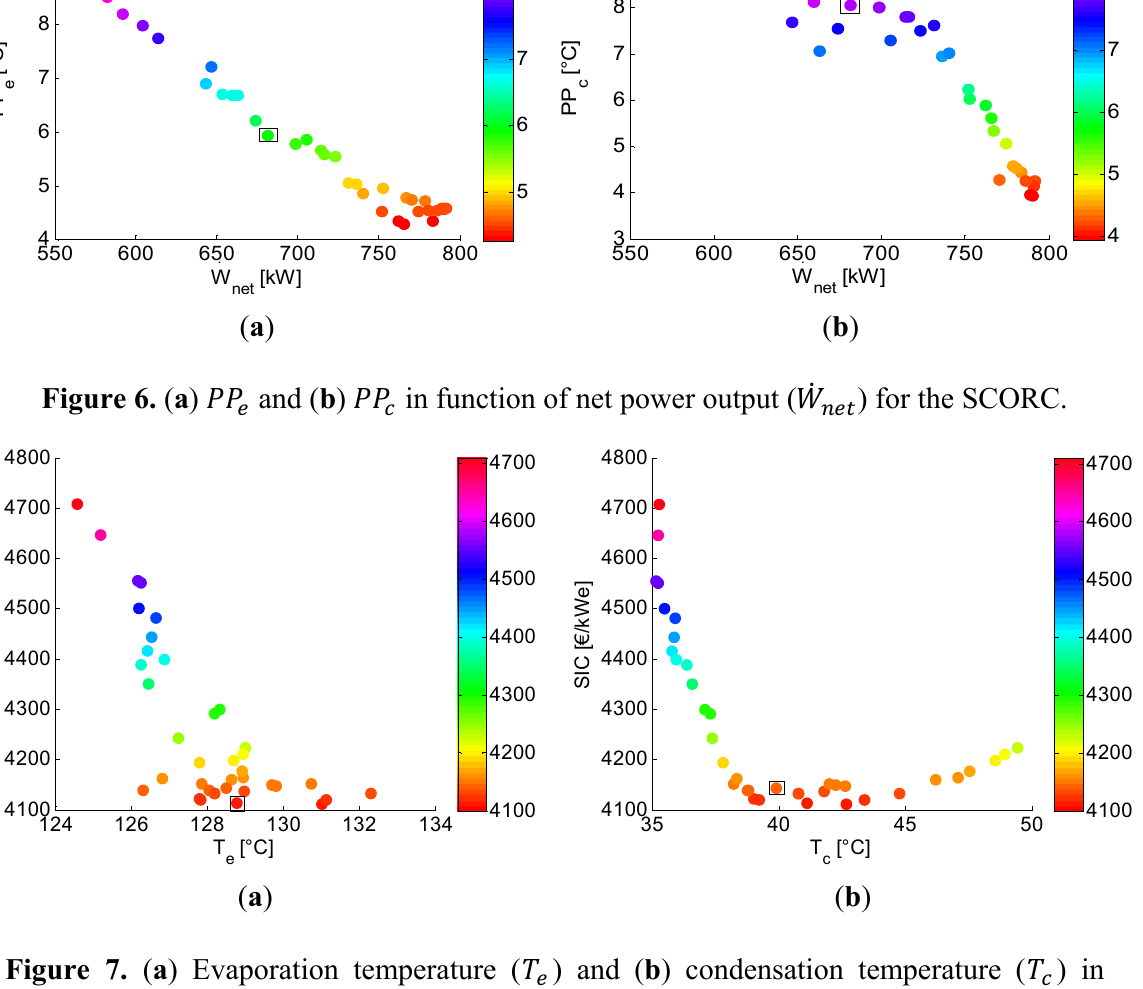
) and ( b ) condensation temperature ( (cid:1846) (cid:3032)